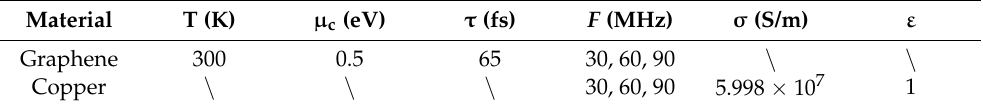
Table 3. Simulation parameters.